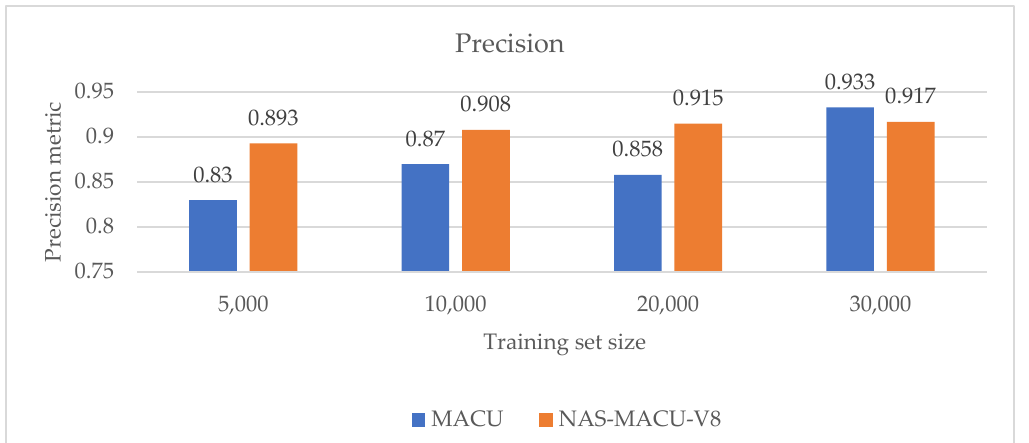
Figure 10. F 1 performance of NAS-MACU-V8 vs. MACU in four different training set sizes.